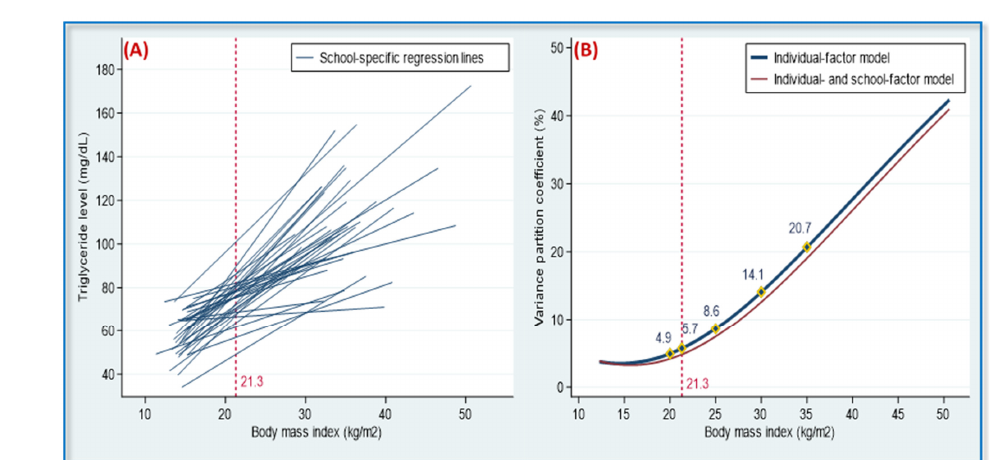
Figure 3. School-specific regression lines and variance partition coefficients (VPC) in 36 adolescent populations. ( A ) The heterogeneity of the regression slopes for the association between body mass index (BMI) and triglyceride levels. ( B ) The VPC revealed a function of BMI values. Note: VPC denotes the percentage of the total variance in terms of individual triglyceride levels, which was attributed to between-schools variability. In the individual-factor model, the VPC values were 4.9, 5.7, 8.6, 14.1, and 21.7% for adolescents with a BMI of 20, 21.3 (mean), 25, 30, and 35, respectively, and in the individual- and school-factor model, the corresponding VPC values were 4.1, 4.8, 7.4, 12.6, and 19.0%. VPC values were adjusted for sex, age, ethnicity, total daily calorie intake, and physical activity. The overall mean of BMI for the 36 adolescent populations was 21.3.